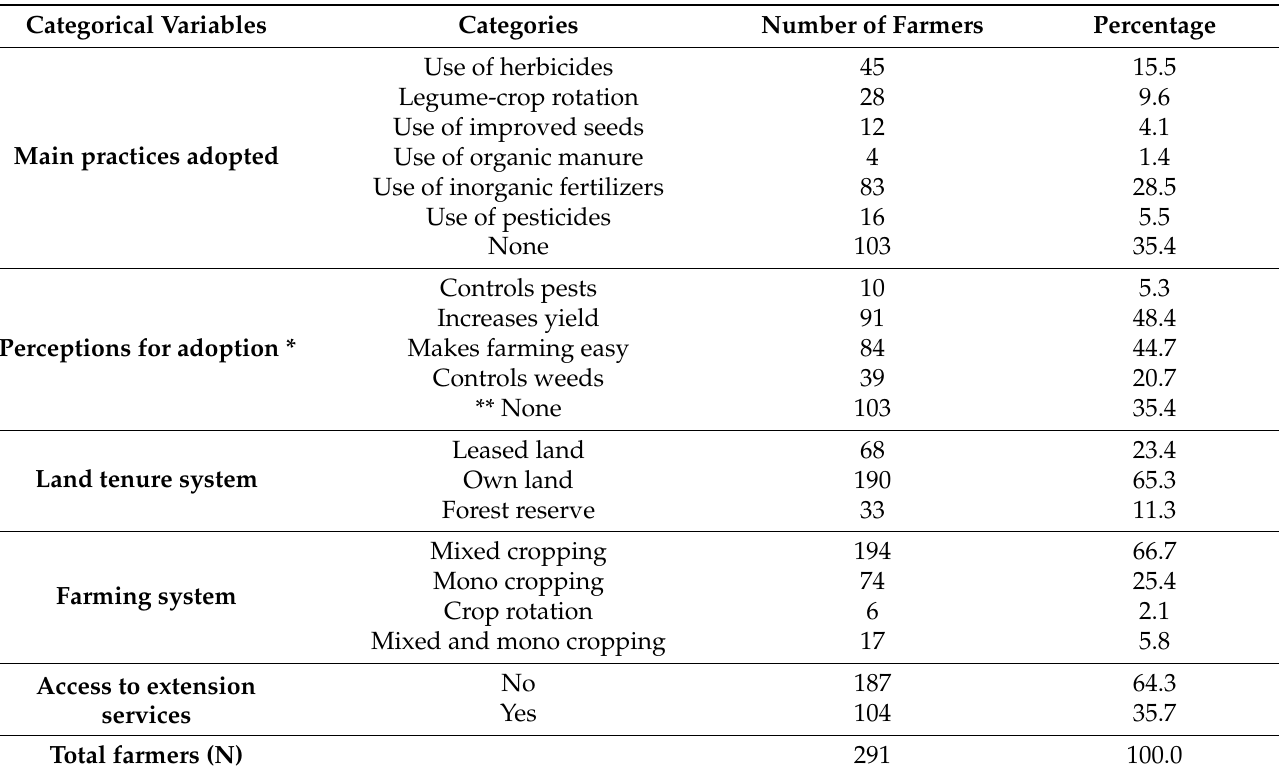
Table 2. Descriptive statistics of the farmers and their farming practices. * The number of farmers that adopt at least one agricultural practice is 188. The total for the categorized perceptions for adoption is 224 farmers because some farmers gave more than one response. The percentage is however out of 188 to reflect the responses against the number of farmers that adopt the practices. ** ‘None’ refers to the farmers who do not adopt any of the practices but rely solely on slash-and-burn. The percentage for ‘none’ is out of the total